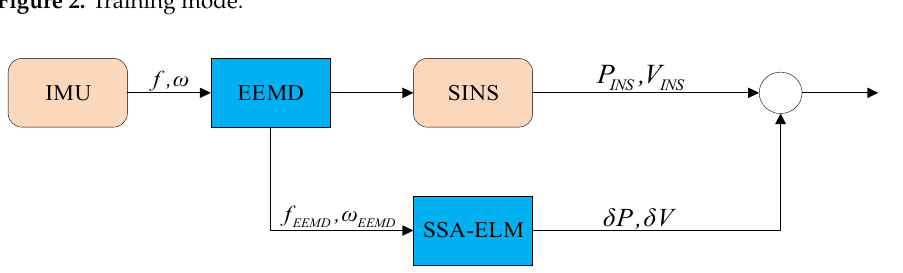
Figure 3. Prediction mode.